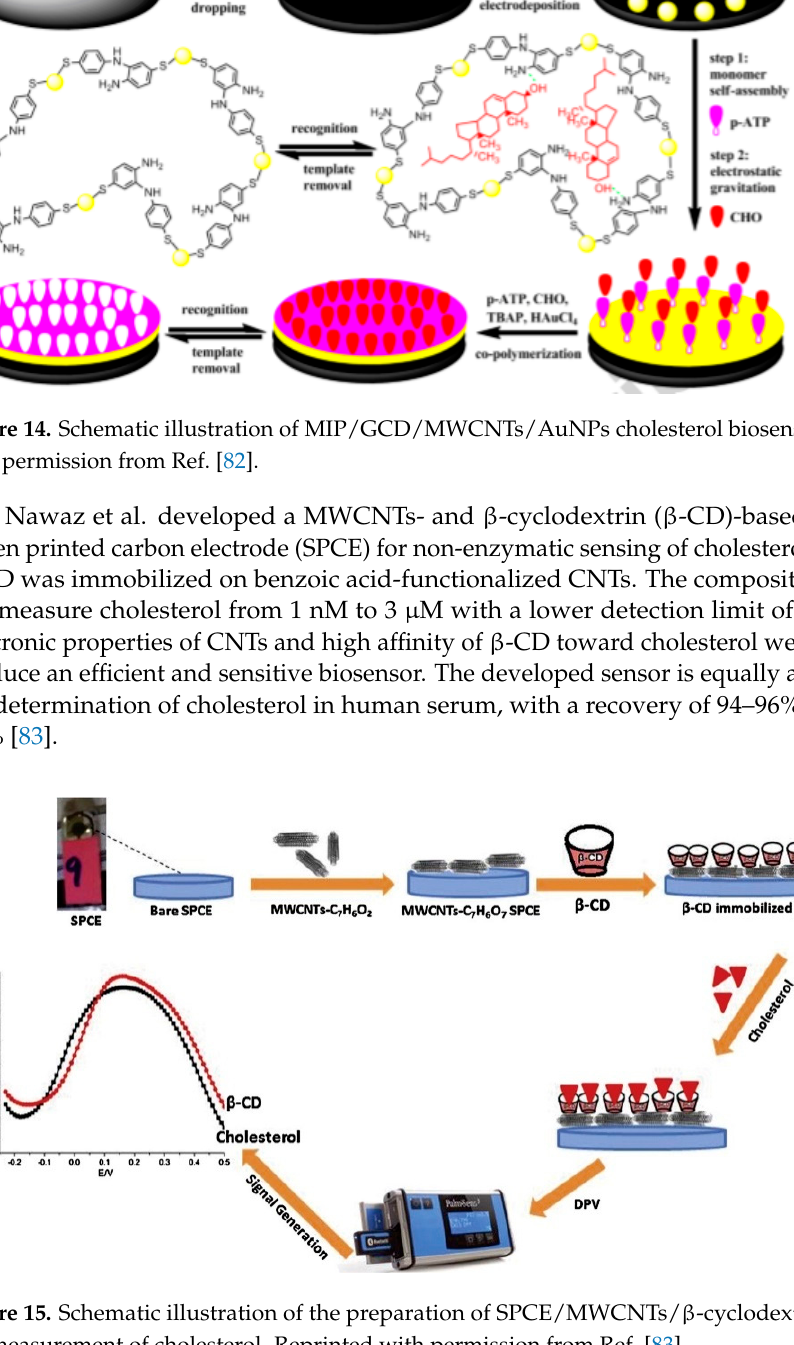
Figure 13. ( A ) Image of carbon nanotube (CCNT) modified electrode ( A ) Image of commercially available screen printed carbon nanotube electrode (DS110CNT). Reprinted with permission from Ref. [81].